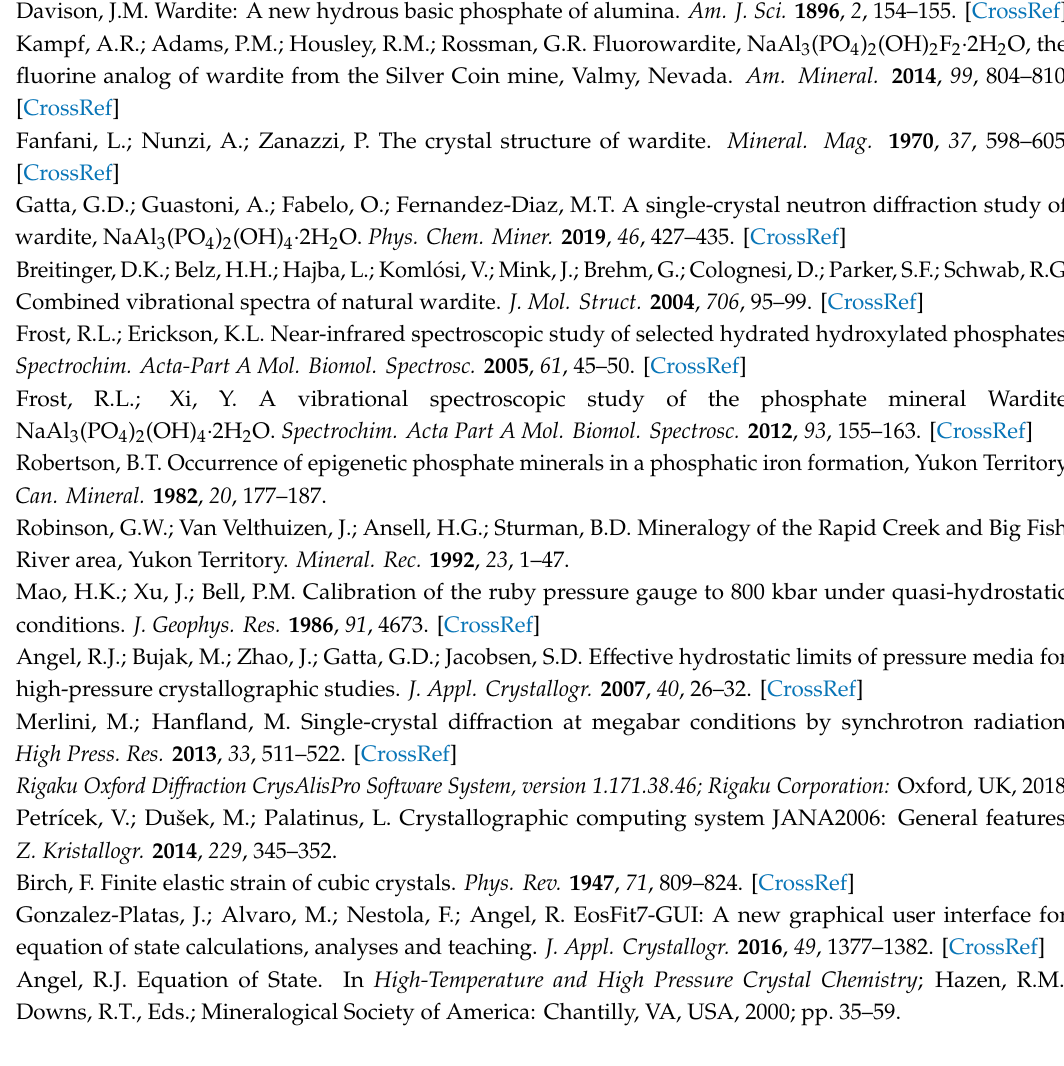
Table S1: Details pertaining to the structure refinements of wardite as a function of pressure; Table S2: (First part ) Fractional atomic coordinates and atomic displacement parameters (Å 2 ) of wardite as a function of pressure (* data collected in decompression), ( Second part ) Selected bond distances (Å) at di ff erent pressure (* in decompression); Table S3: Evolution of the polyhedral volumes (in Å 3 ) with pressure in wardite. Average uncertainties on the volume values pertaining to the Na-polyhedron, Al-octahedra and P-tetrahedron are estimated to be ~0.3 Å 3 , ~0.1 Å 3 and ~0.01 Å 3 , respectively (on the basis of the largest and smallest volume values generated by the uncertainties of the bond distances); Table S4: Refined compressional parameters pertaining to the P-, Al- and Na- polyhedra in wardite, based on isothermal II -BM Equation of State fits (* fixed parameter). Author Contributions: G.D.G. and D.C. conceived and designed the study, produced and managed the article structure; A.G. provided the sample, its mineralogical description and performed the electron microprobe analysis; G.D.G., P.L. and N.R. performed the SC-XRD characterization of the mineral sample in home lab at the Univ. Milan, whereas D.C. and M.H. collected the in-situ high-pressure data at ESRF; G.D.G., D.C. and P.L. discussed the results based on the experimental findings at high pressure. All authors have read and agreed to the published version of the